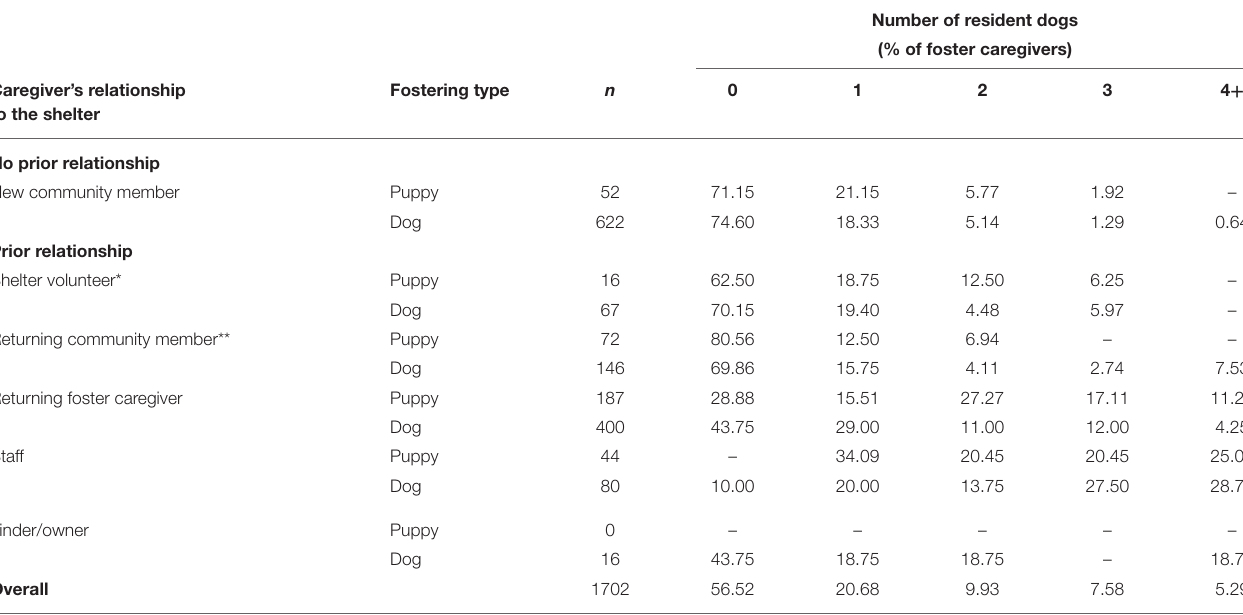
TABLE 5 | Foster caregivers and their relationship to shelter by fostering type and number of resident dogs living in the home.